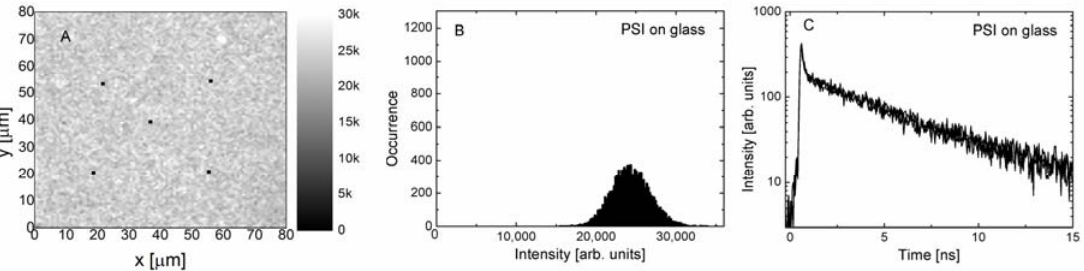
Figure 2. ( A ) Fluorescence intensity map measured for photosystem I (PSI) complexes on a glass substrate using the excitation wavelength of 485 nm. ( B ) Histogram of fluorescence intensity extracted from the map. ( C ) Fluorescence intensity decays measured for the locations marked by spots in (A).